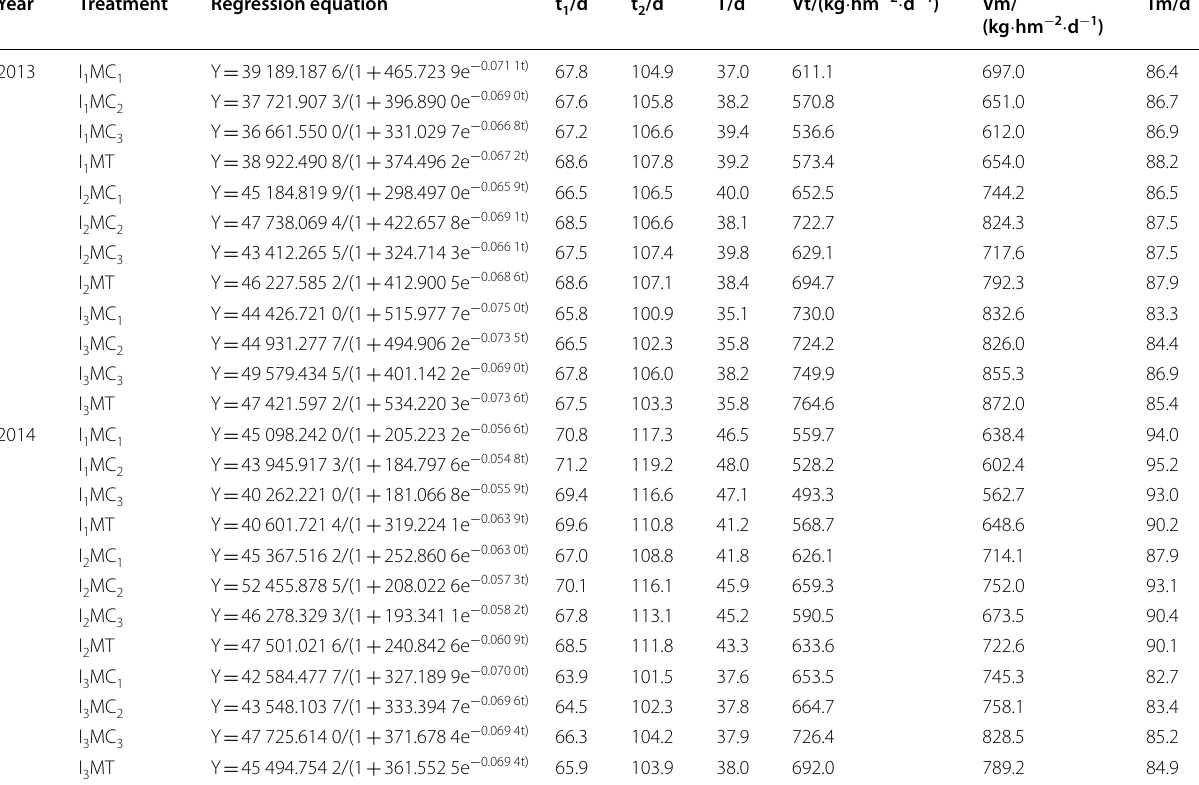
I 1 , I 2 , and I 3 represent 300, 480 and 660, mm drip irrigation amounts, respectively; MT, MC 1 , MC 2 , and MC 3 represent manual topping as control, 450, 750, and 1 050 mL